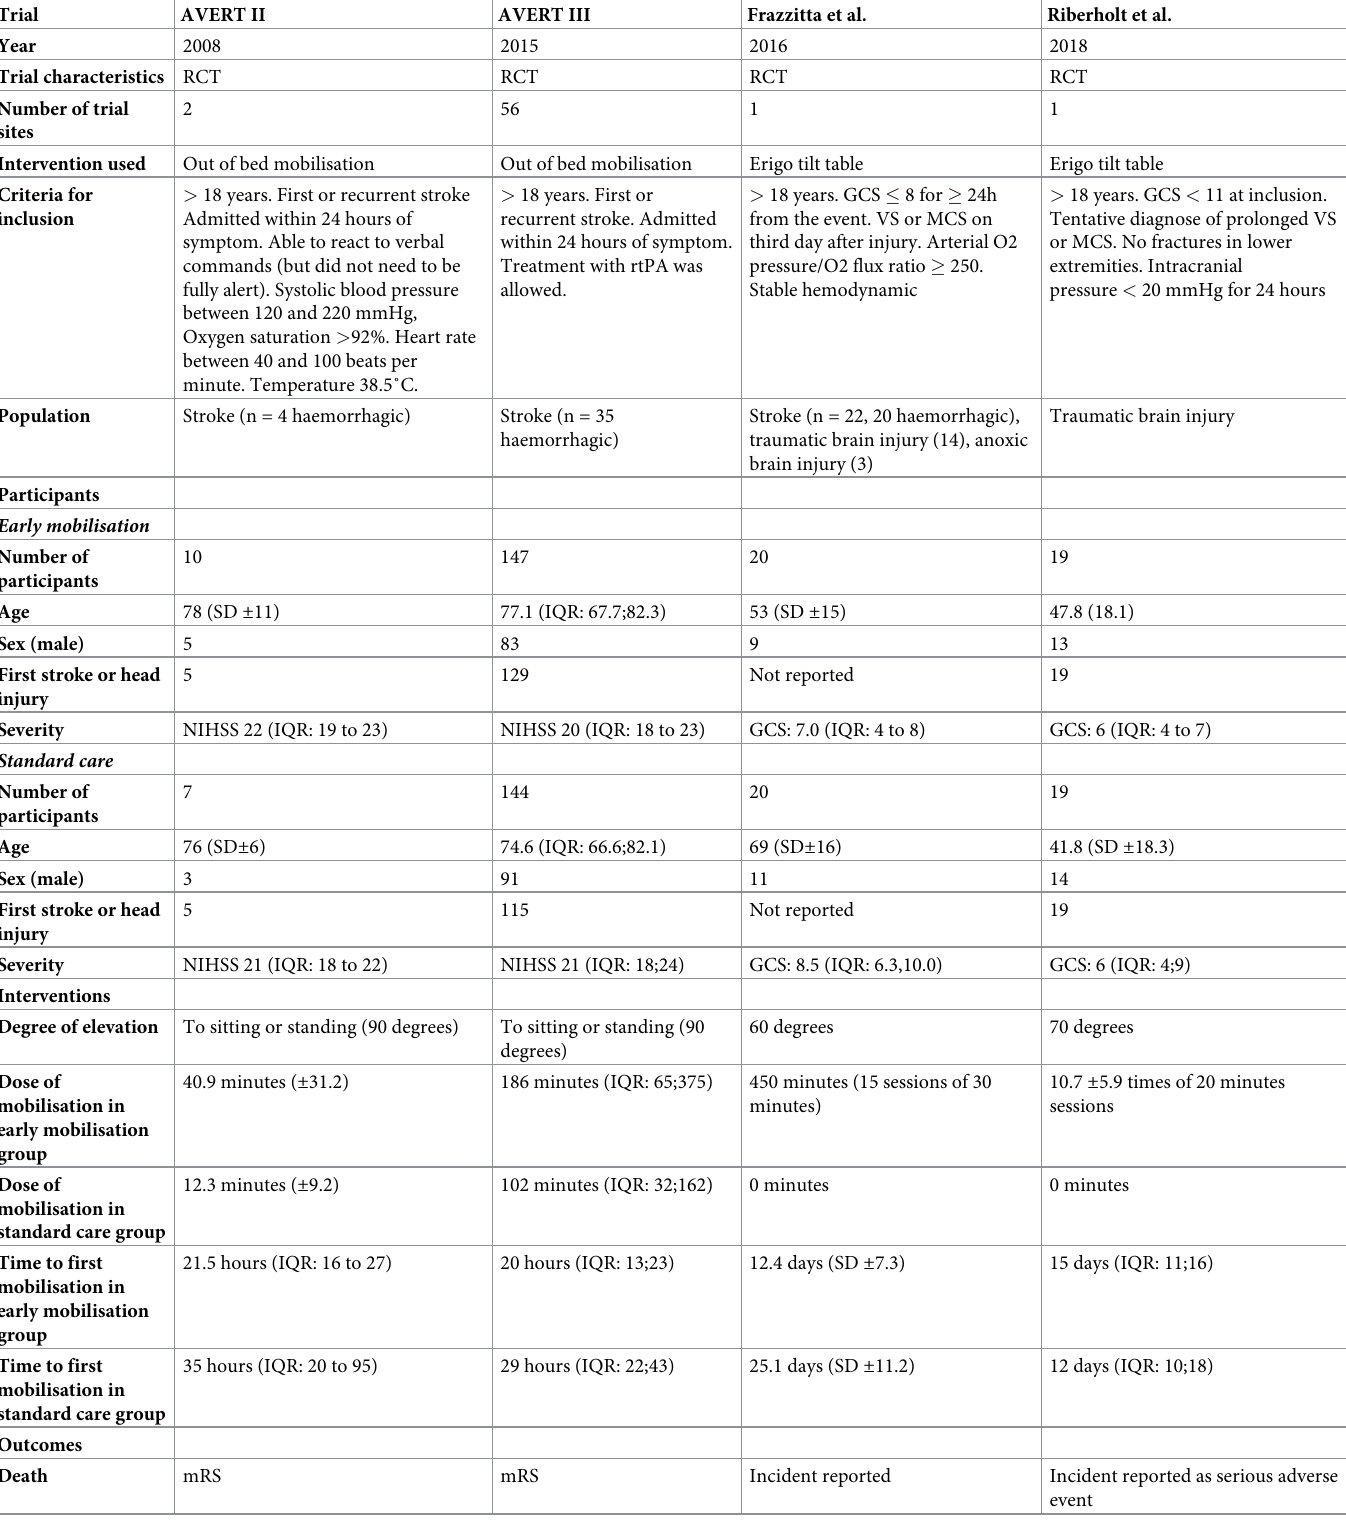
Table 1. Characteristics of included randomised clinical